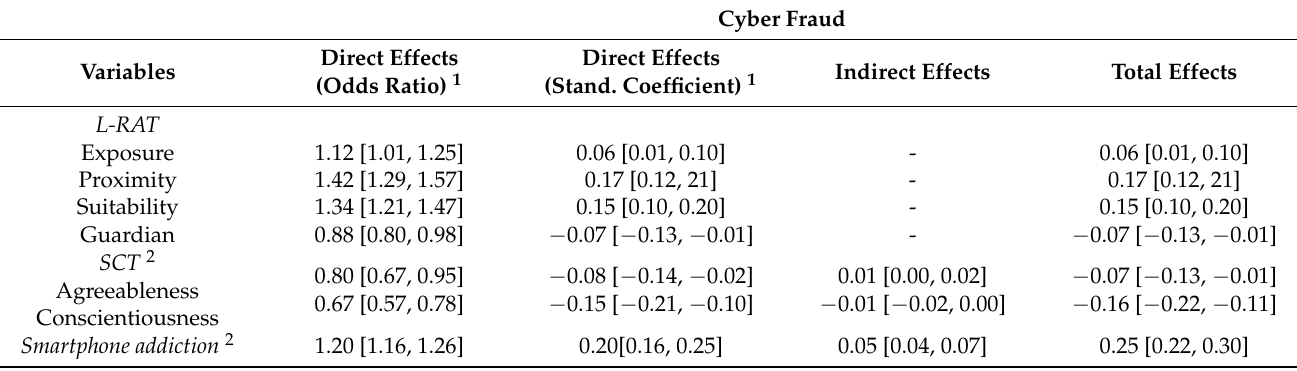
Table 1. Unstandardized and standardized parameter estimates of L-RAT, SCT, and smartphone addiction predictors of cyber fraud in a national representative sample of users ( n =